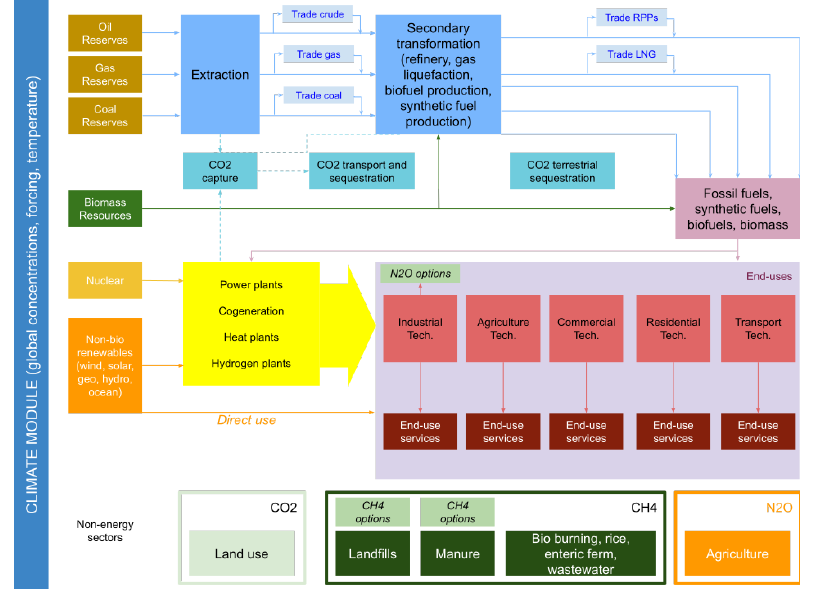
Figure A1. TIAM reference energy